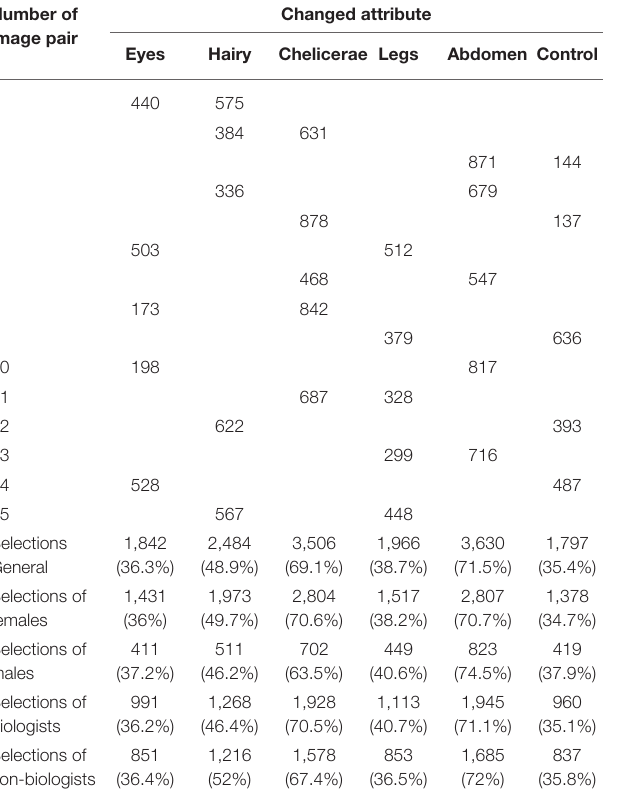
TABLE 3 | A specific number of selections for each pair for each image in fear perception testing (general, gender, and biological education). Number of image pair